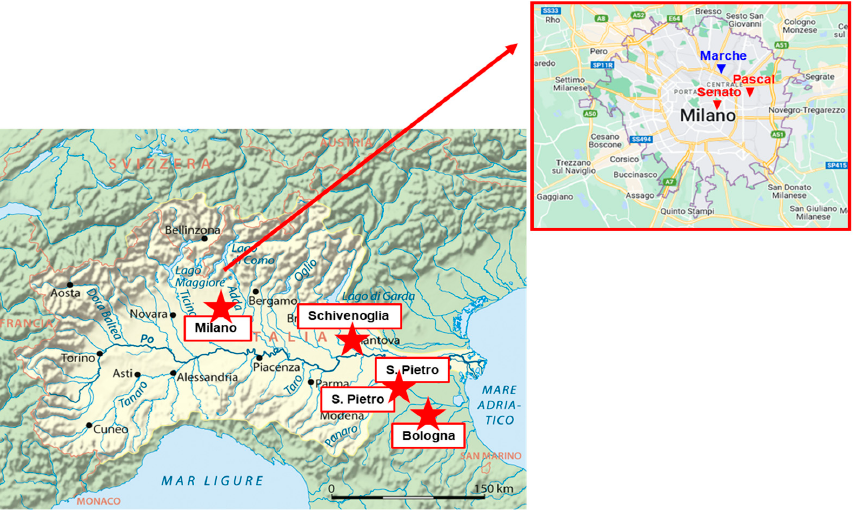
Figure 1. Map of the Po Valley study area (https://geography.name/po-valley/ accessed on 2 December 2022); enlarged insert: map of the metropolitan area of Milan (©2019 Google). Symbols indicate the locations of all sampling sites.